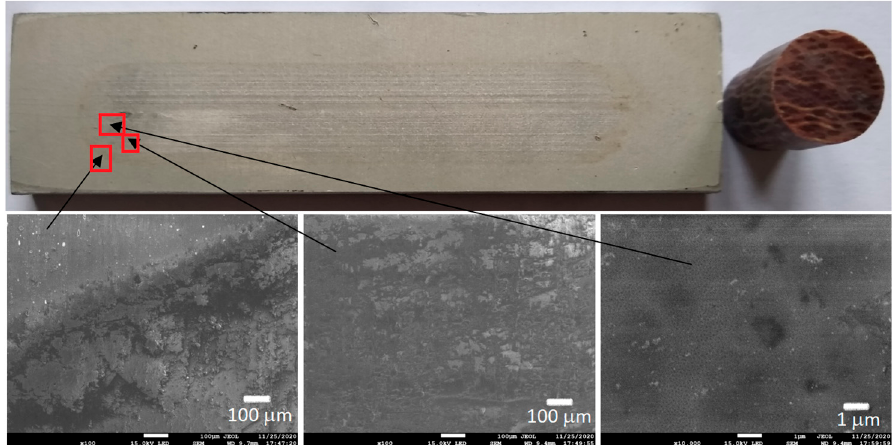
Figure 11. Photographs and SEM micrographs of Al 2 O 3 /IF-WS 2 tribological pairs after a tribological test with PF + jute.